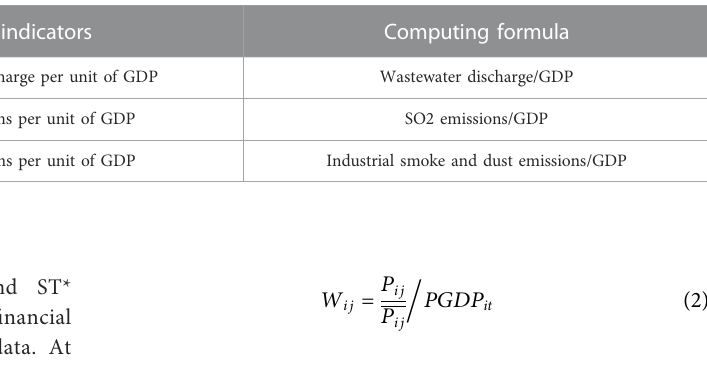
TABLE 1 Environmental regulation evaluation